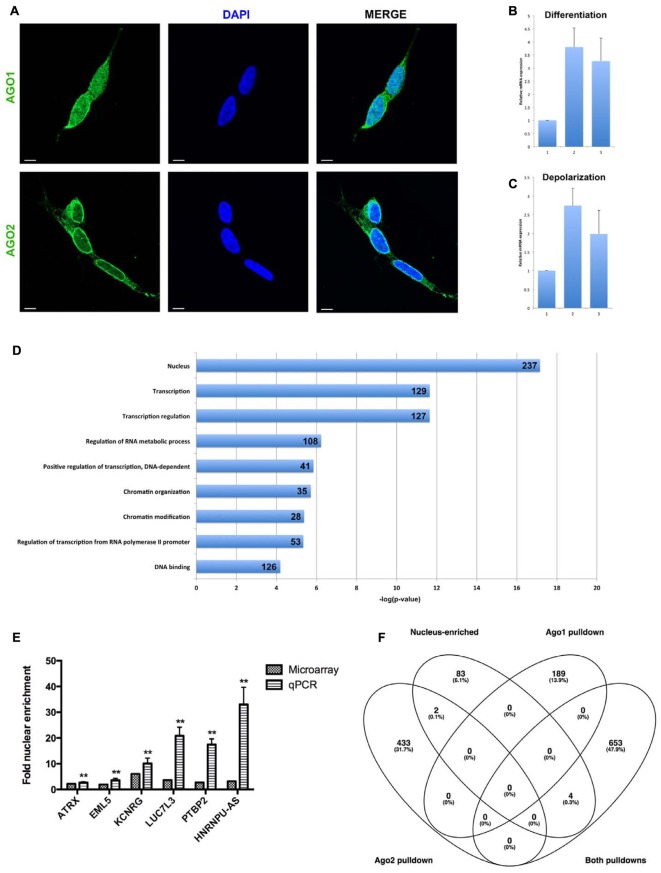
Analysis of nuclear mRNA by Argonaute (Ago)1/2 RIP-seq and exon microarray. (A) Ago1 and Ago2 are differentially distributed in the nucleus. Single slice images were taken on a Zeiss LSM800 confocal microscope at 63X magnification with oil-immersion. Scale bar, 5 μm. (B) qPCR detection of MAZ mRNA abundance in response to sequential ATRA and BDNF differentiation of SH-SY5Y cells. (C) qPCR detection of MAZ mRNA abundance in response potassium-induced depolarization of differentiated SH-SY5Y cells. (D) Functional analysis of mRNAs pulled down by both Ago1 and Ago2 showed strong relation to transcriptional regulation. (E) Taqman qPCR validation of microarray-detected nuclear mRNA enrichment. (F) Nucleus-enriched mRNAs are not associated with Ago1 or Ago2. ∗∗p < 0.01.